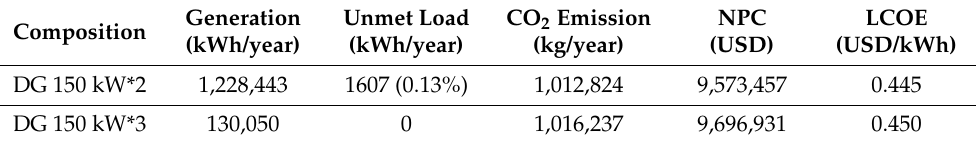
Table 5. Simulation result of topology_A (diesel-only system).